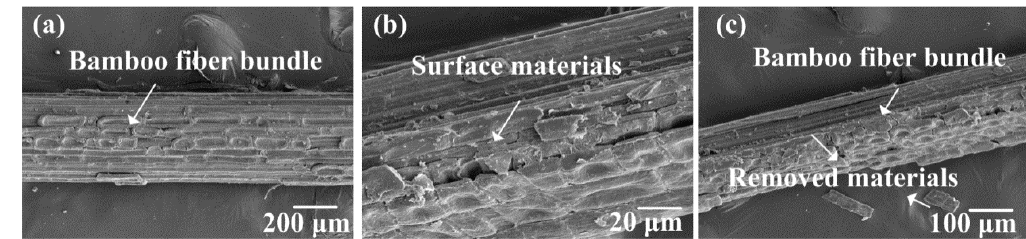
Figure 5. SEM images of the surface of the 2 wt.% NaOH-treated bamboo fiber bundles.